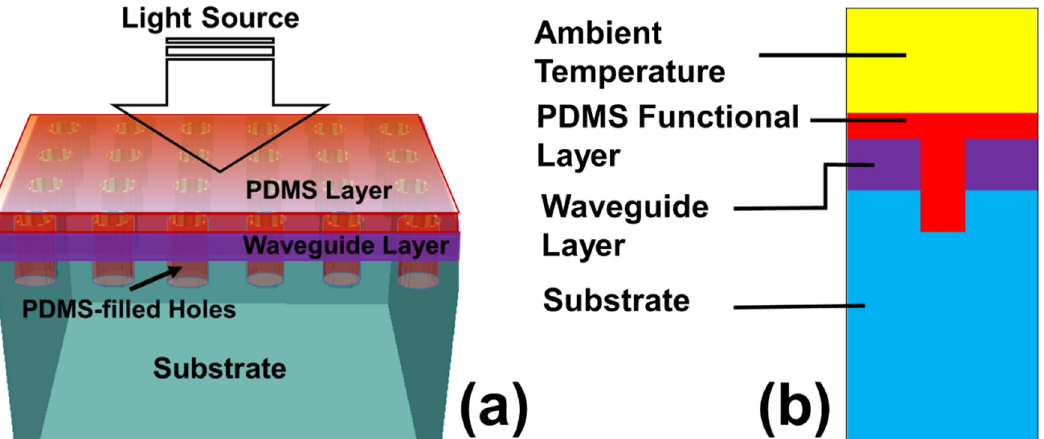
Figure 2. Thermal sensing mechanism of the device: ( a ) A PDMS functional layer was deposited on the top and filled in the PhC holes. Light source incident on the device to excite the Fano-resonances; ( b ) Unit cell model with PDMS functional layer and ambient atmosphere where the temperature change was to be measured.